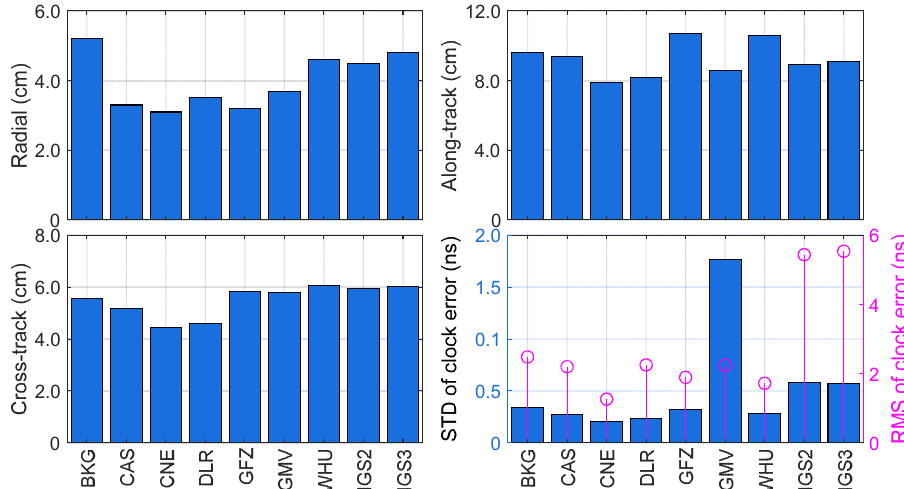
Figure 4. The accuracy of GLONASS SSR products. The STD (Left y axis and blue) and RMS (Right y axis and magenta) of clock errors is presented in the lower-right subplot.